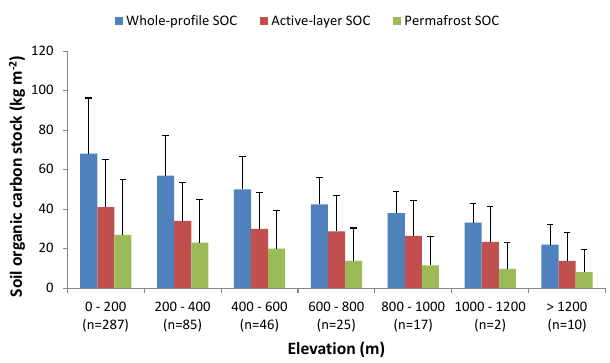
Fig. 2. Average whole-profile, active-layer, and permafrost SOC stocks in each elevation zone of Alaska. Error bar is the standard deviation and n is the number of observations.